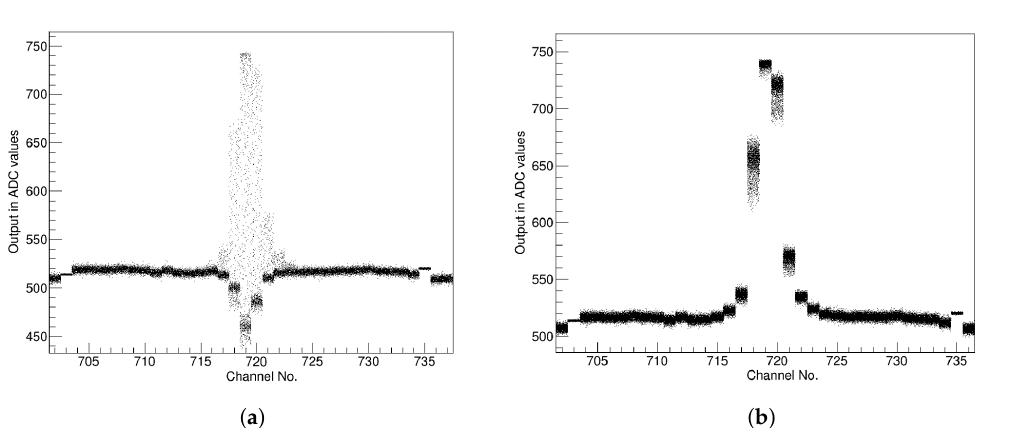
Figure 6. ( a ) Non-synchronised readout between the LD-1060 and VELO R-sensor; and ( b ) synchronised readout between the LD-1060 and VELO R-sensor. Without synchronisation, the output pulse is sampled at random points (even negative points), decreasing the signal quality